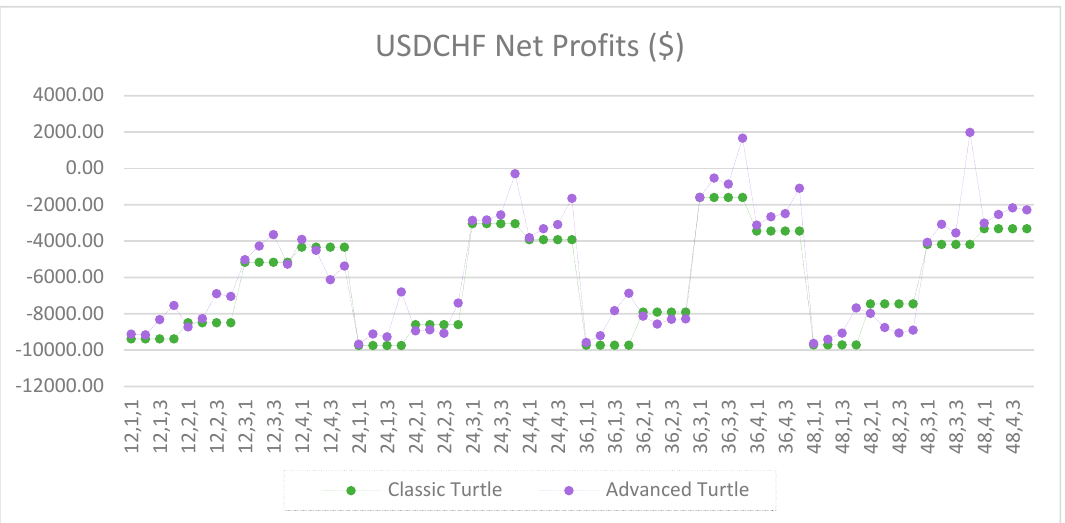
Figure A23. Net profits of USDCHF between the classic and the advanced Turtle systems for every combination of N, X, Y for the medium parameters (40, 80).